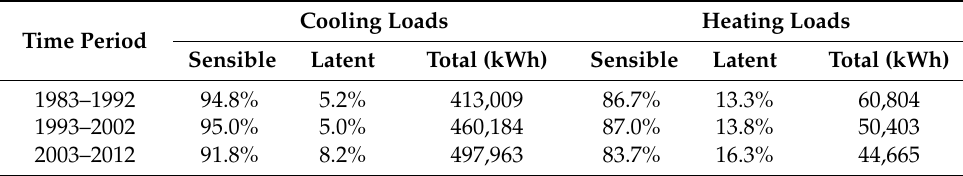
Table 7. Latent and sensible loads for the 1983–2013 period.